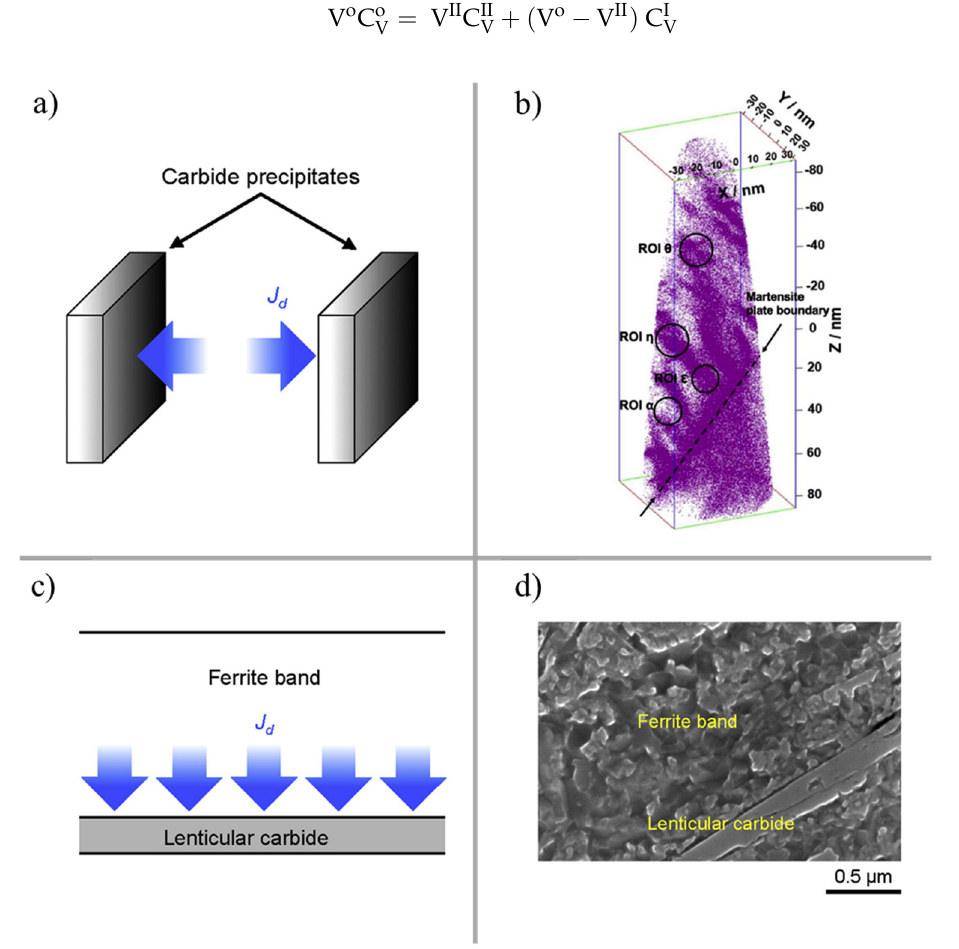
Figure 12. ( a , c ) Schematic of carbide thickening within DERs and WEBs; ( b ) experimental evidence for carbon redistribution and precipitation; ( d ) formation of lenticular carbides [103].